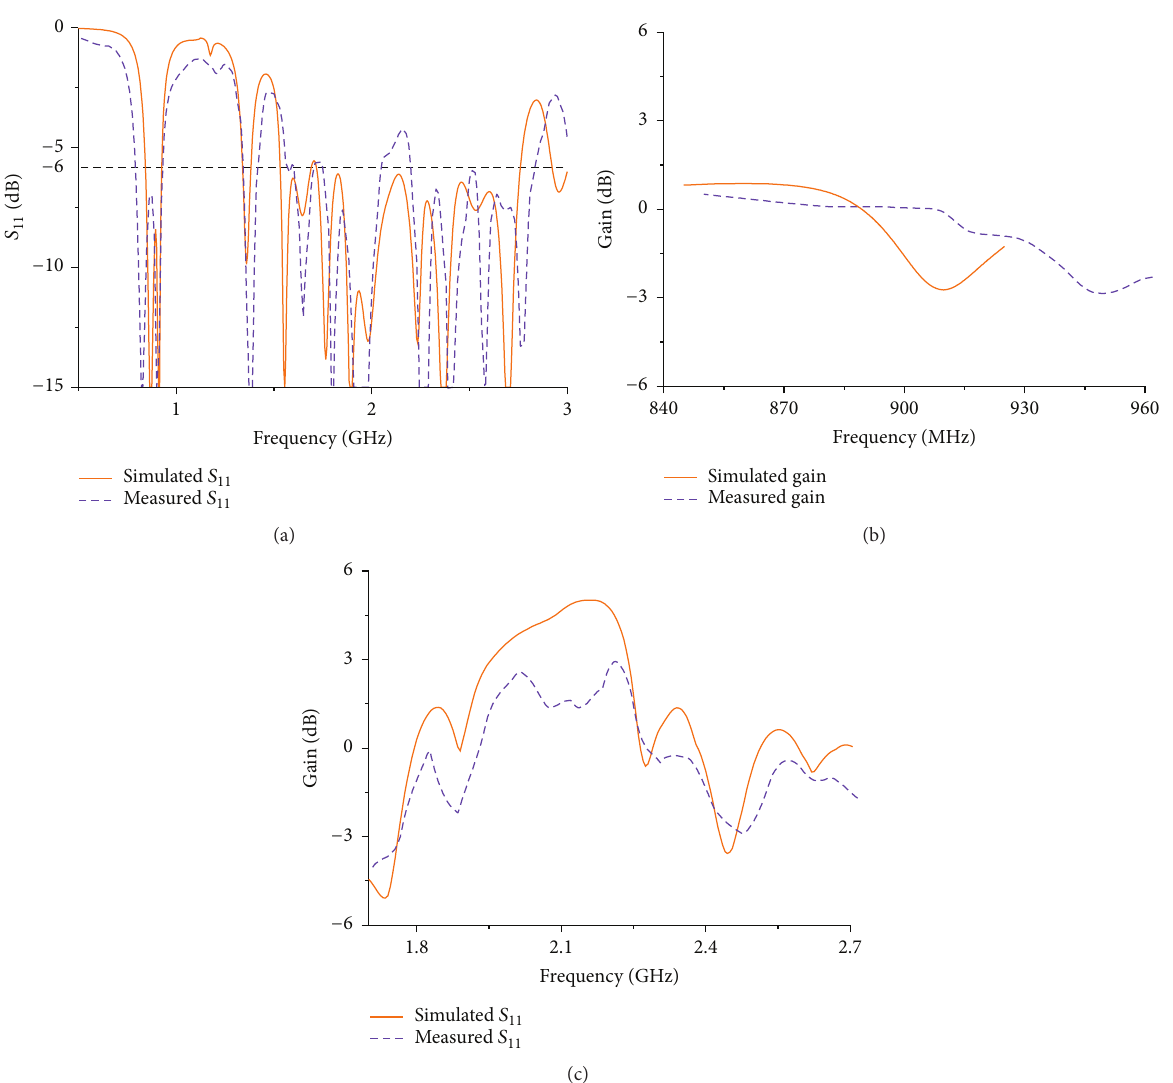
Figure 4: Comparison of simulated and measured characteristics of the proposed antenna: (a) 𝑆 11 , (b) gain at lower resonant frequency band, and (c) gain at higher resonant frequency